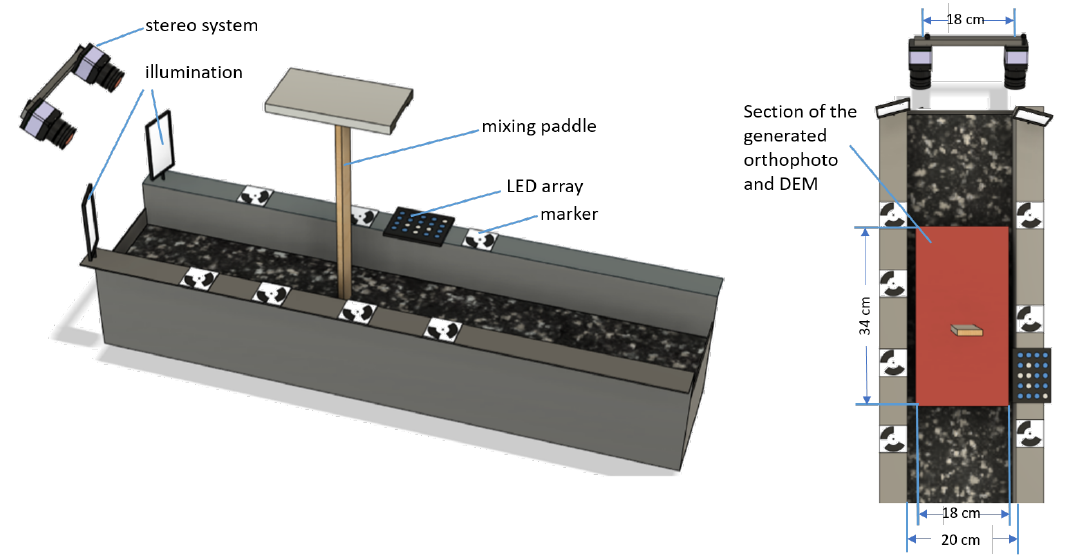
Figure 1. Experimental set-up for data generation. The geometric dimensions can be found in the top view (right).